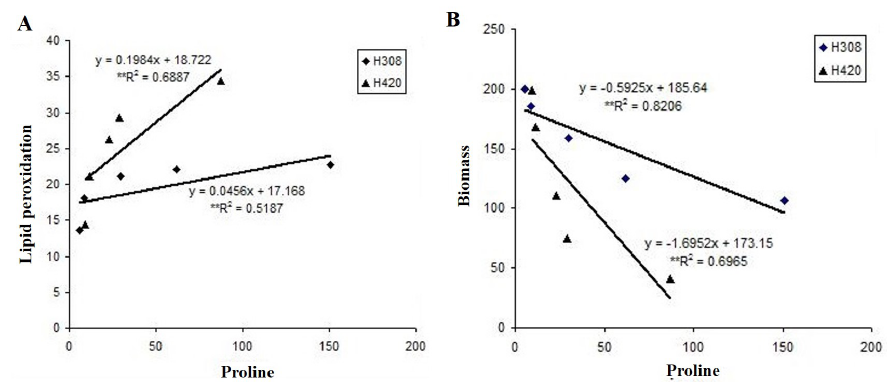
Fig. 5. The correlations between proline and lipid peroxidation (A) or biomass (B) in two canola genotypes (H308, H420).** , * means significant at P<0.01 and P<0.05, respectively.